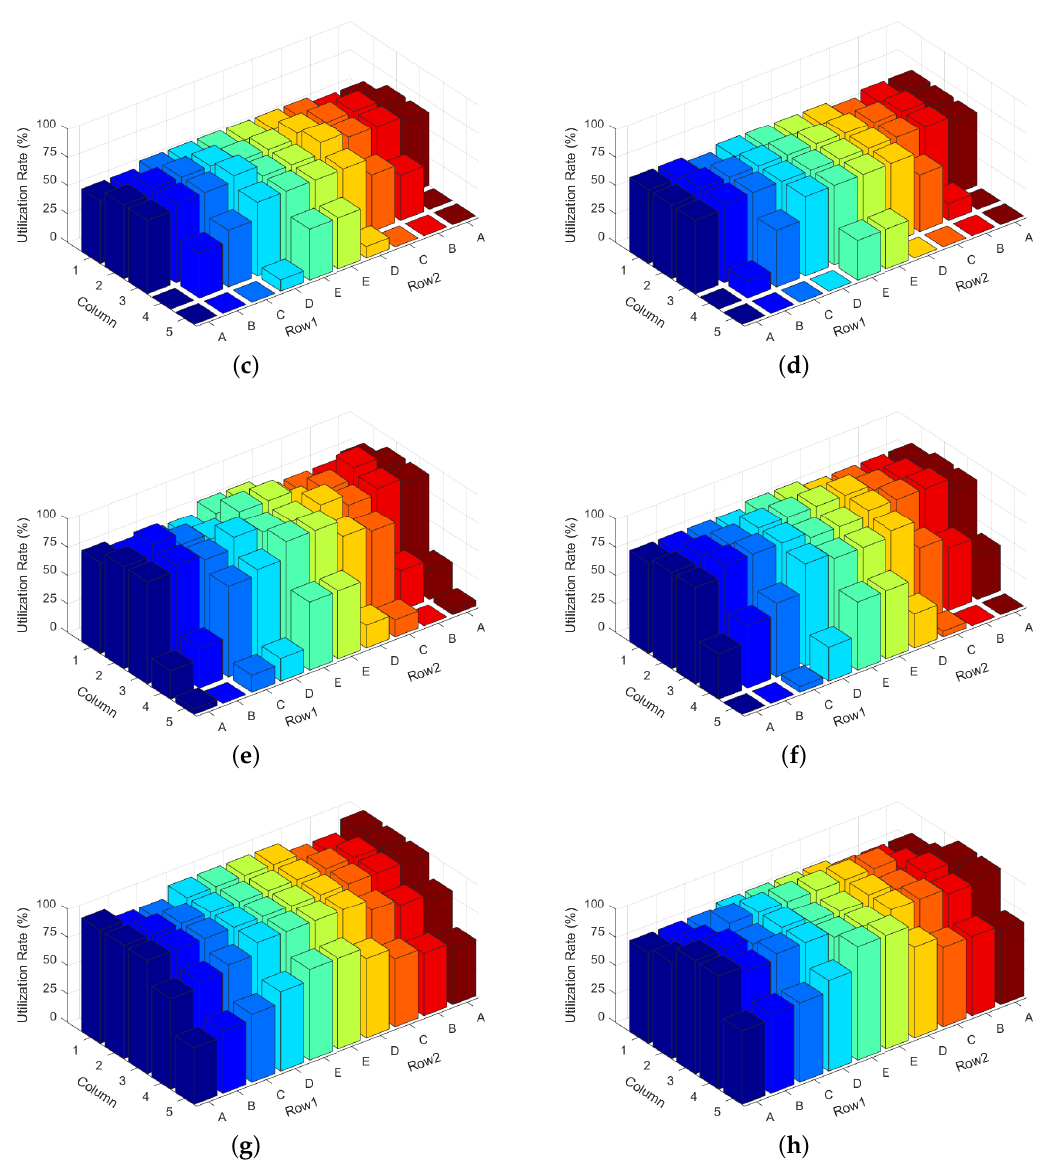
Figure 10. Workload distributions achieved by inlet temperature-aware workload allocation